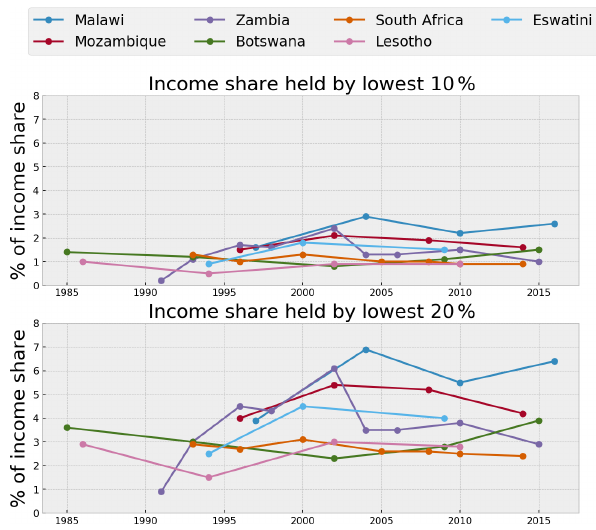
Figure 2. Percentage of income share held by lowest 10% and 20% income population in the southern Africa countries (data source: the World Bank’s World Development